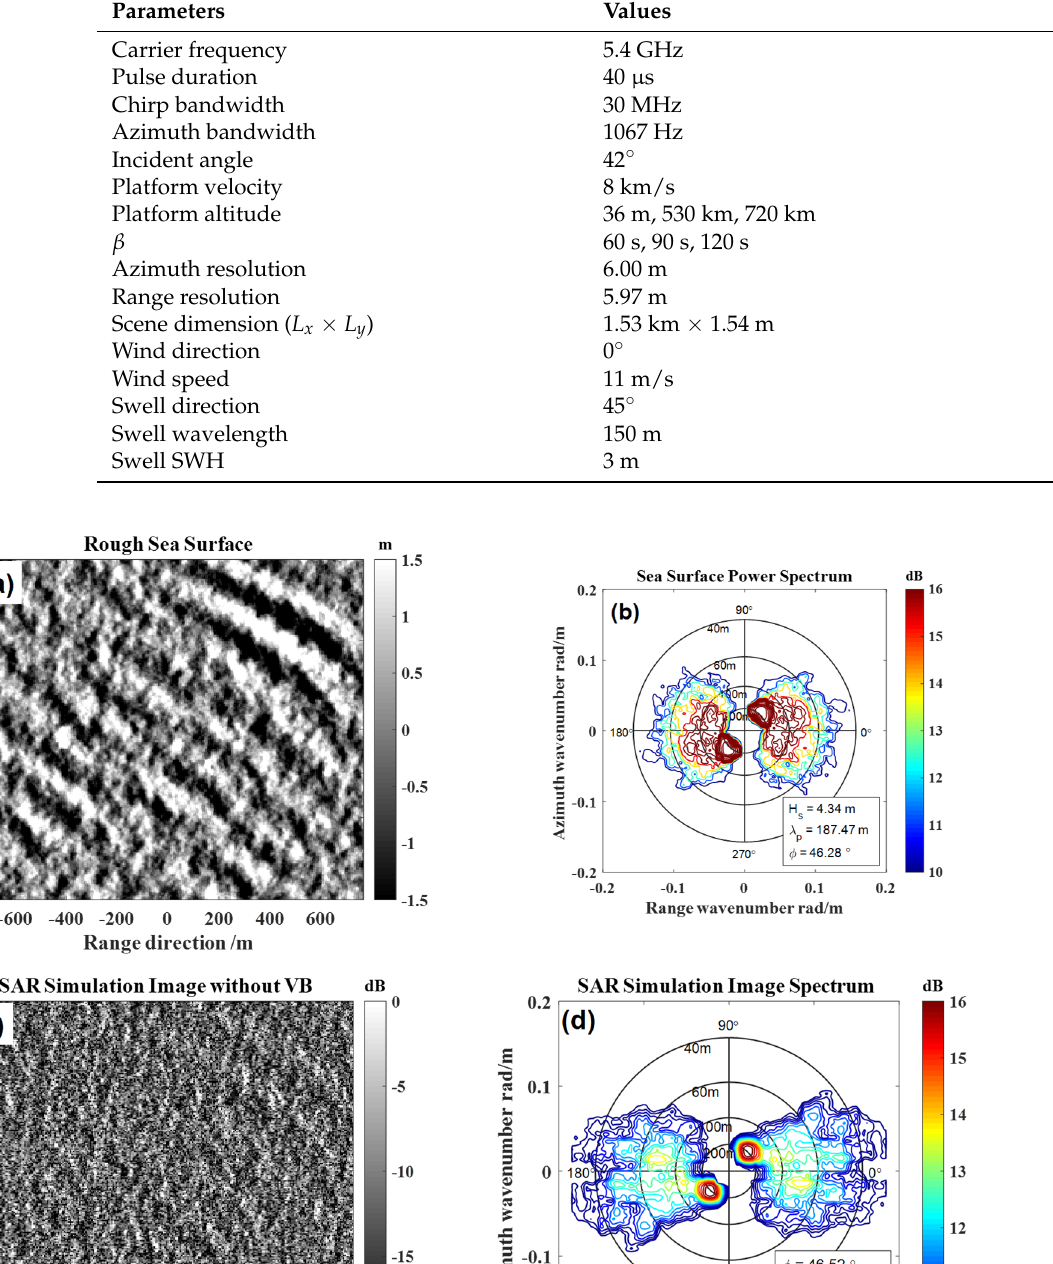
Table 3. The parameters of radar and ocean waves.